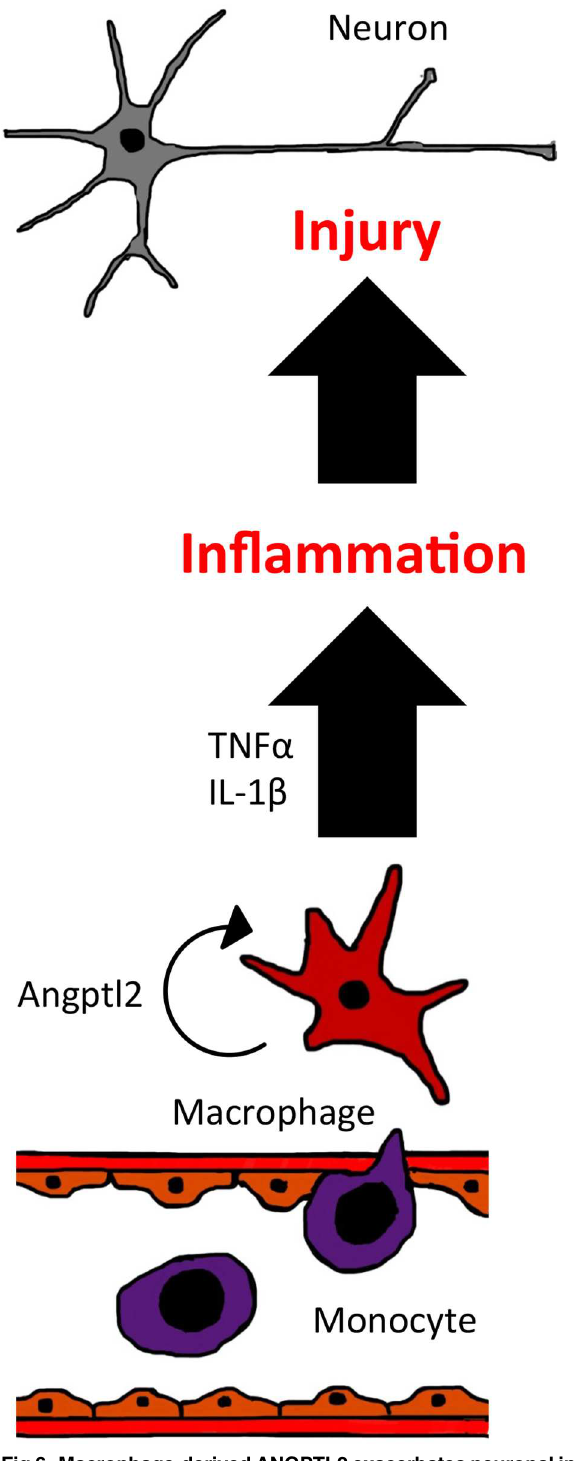
Fig 6. Macrophage-derived ANGPTL2 exacerbates neuronal injury in the acute phase of ischemic stroke. Schematic diagramshowingANGPTL2 function in ischemicstroke. In normal conditions, brain resident cells express little ANGPTL2. However, followingischemic stroke, bone marrow-derived macrophages infiltrate the brain interstitium and secrete abundantANGPTL2. Subsequently, ANGPTL2 from activated macrophages induces those same macrophages to increaseexpressionof